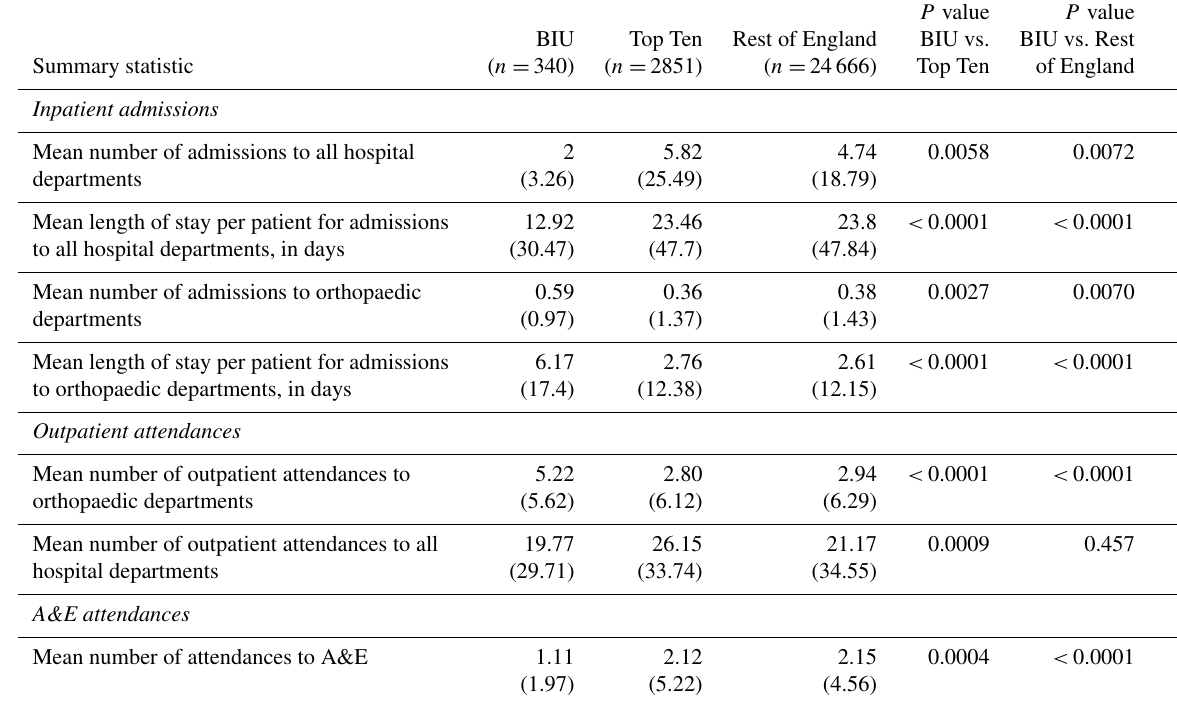
Table 4. Healthcare resource utilisation per patient during the 24-month post-discharge period after index osteomyelitis surgery. Figures represent mean and (standard